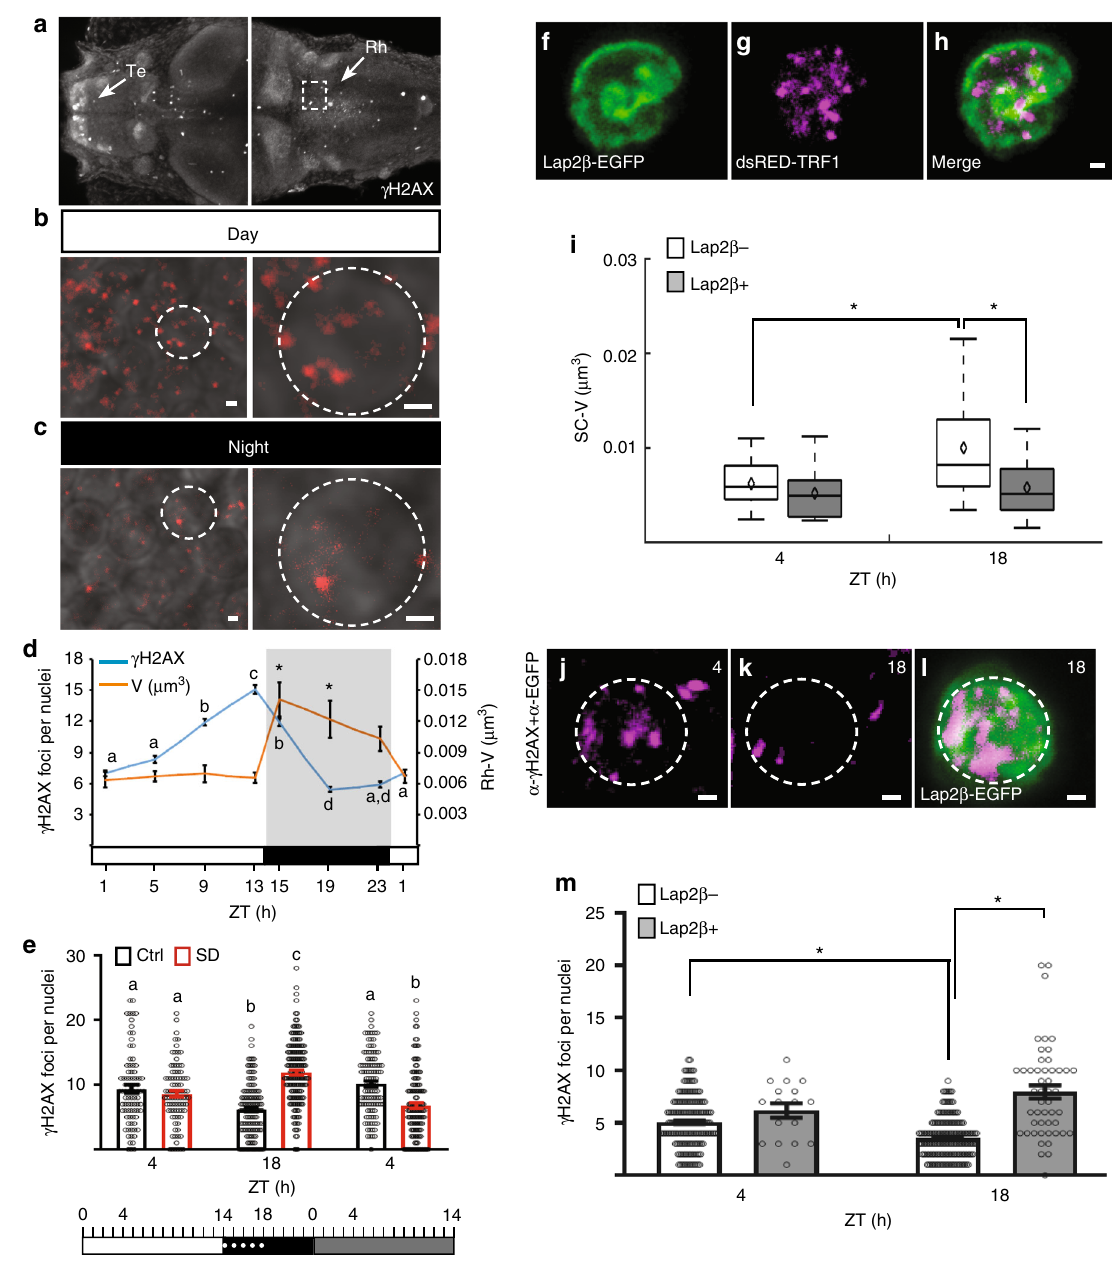
Fig. 3 Chromosome dynamics are essential for reducing the number of accumulating DSBs. a – c Dorsal view of 6 dpf larvae stained with γ H2AX. a Arrows indicate the telencephalon (Te) and rhombencephalon (Rh). Dashed box showing the Rh represents the area analyzed in d and e . Representative images from the Rh region during day ( b ) and night ( c ) are shown. Dashed circle indicates a single neuron. d The number of DSBs ( P = 1 × 10 − 16 , F = 118, degrees of freedom = 7) and chromosome dynamics (* P = 8 × 10 − 7 , F = 7, degrees of freedom = 7) in single nuclei over 24 h, in 14 h light/10 h dark cycle. Determined by one-way ANOVA followed by a Tukey test. Lower case letters indicate signi fi cant changes between γ H2AX groups. Asterisks indicate signi fi cant changes between chromosome dynamics groups. White and black horizontal bars represent light and dark periods, respectively. e Numbers of DSBs (dot plot, means ± SEM). Ctrl: day ( n = 83 cells), night ( n = 131 cells), subjective day ( n = 105 cells). SD: day ( n = 86 cells), night ( n = 170 cells), subjective day ( n = 135 cells). P = 1 × 10 − 6 , F = 62.04, degrees of freedom = 2, determined by two-way ANOVA followed by a Tukey test. White, black, and gray rectangles represent day, night, and subjective day, respectively. Dotted white line represents the sleep deprivation (SD) period. f – h Co- expression of Lap2 β -EGFP ( f ) and human telomeric markers ( g ) in SC-neuronal nucleus. i Volume of chromosome dynamics in control (Lap2 β − , day: n = 25; night: n = 21 cells) and Lap2 β -overexpressing cells (Lap2 β + , day: n = 25; night: n = 19 cells). * P = 0.026, F = 5.1, degrees of freedom = 1, determined by two-way ANOVA followed by a Tukey test. j – l Representative images of double immunohistochemistry using α - γ H2AX (magenta) and α -EGFP (green) in single SC neurons during day ( j ) and night ( k , l ). Dashed circle indicates a single nucleus. m The number of DSBs (dot plot, means ± SEM) in control (Lap2 β − , day: n = 177; night: n = 177 cells) and Lap2 β -overexpressing cells (Lap2 β + , day: n = 17; night: n = 49 cells). * P = 1 × 10 − 6 , F = 18.8, degrees of freedom = 1, determined by two-way ANOVA followed by a Tukey test. Zeitgeber time (ZT4)-day, ZT18-night. Boxplots: black diamond represents the mean, boxes indicate the median and the 25th-to-75th percentiles, whiskers extend to the most extreme data points. Letters or asterisks indicate signi fi cant differences. Scale bar = 1 µ